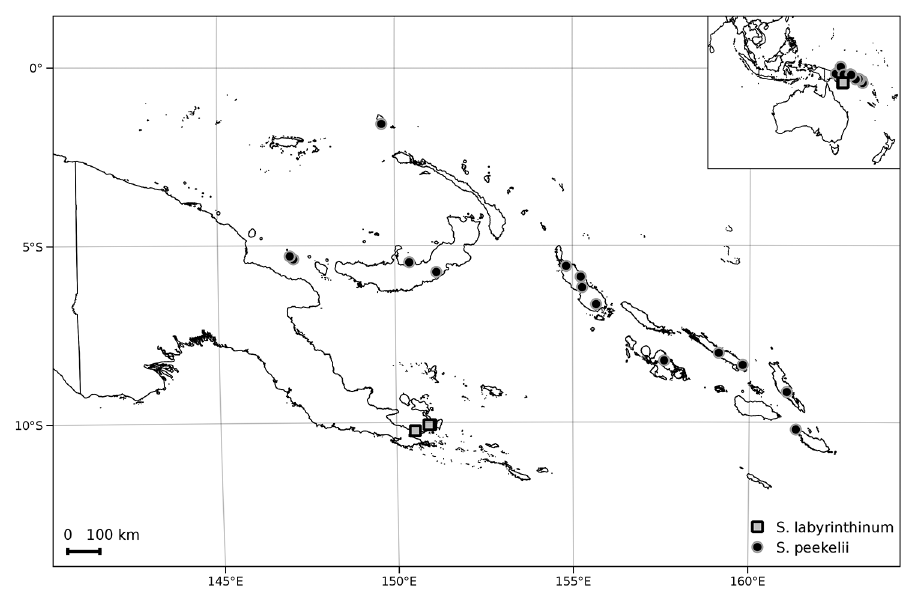
Figure 2. Distribution of Solanum labyrinthinum and S. peekelii